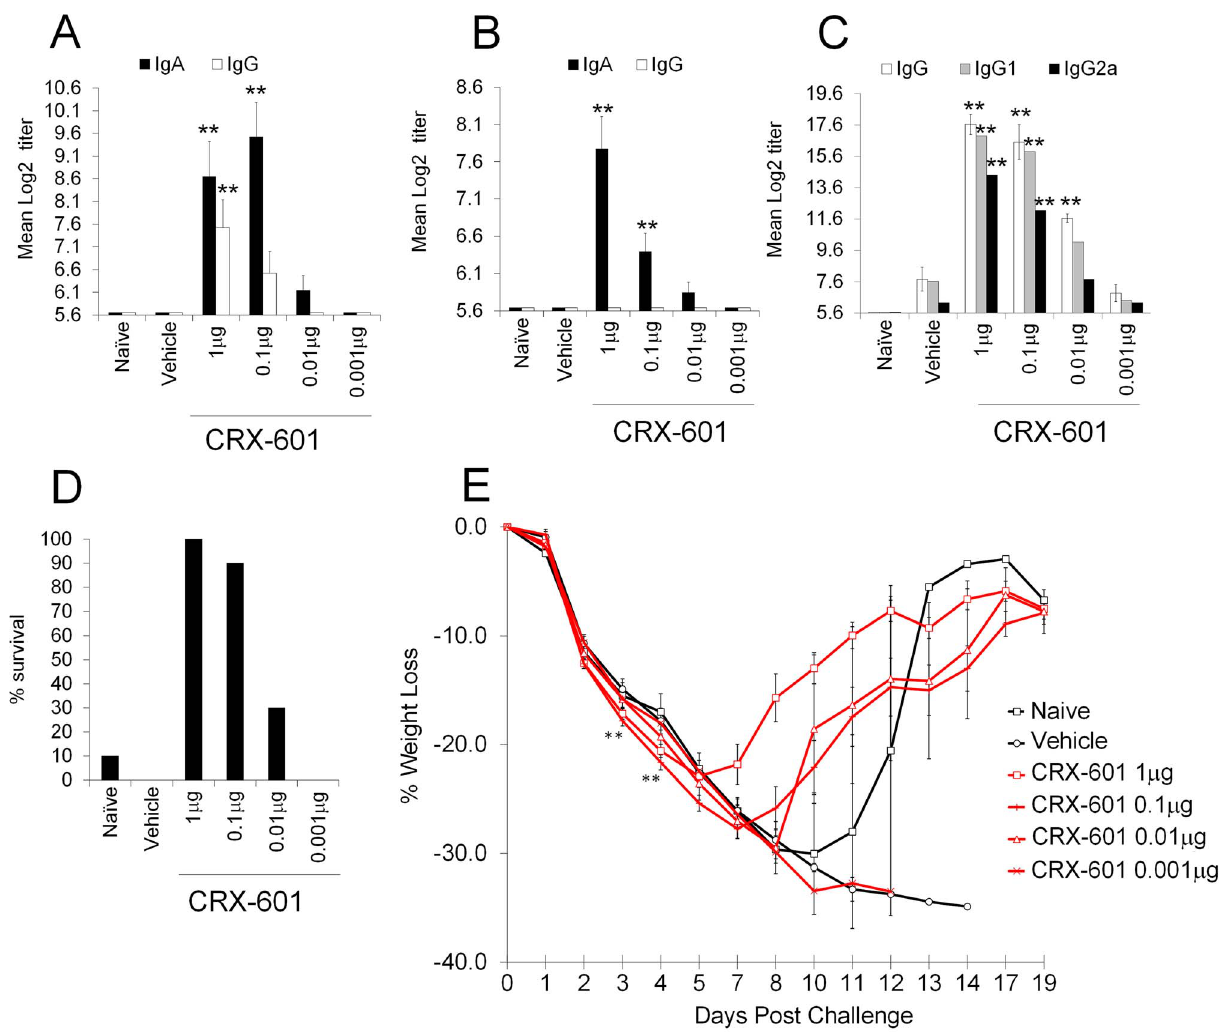
Figure 3. Intranasal vaccination induces both mucosal and systemic immune responses. Anti-influenza total IgG and IgA titers in vaginal (A) and tracheal wash (B) as well as total IgG, IgG1, IgG2a titers in serum samples from mice vaccinated intranasally with split influenza virus antigen (A/Uruguay/716/2007 (H3N2)) and CRX-601 liposomes were examined 14 days post boost vaccination. Percent survival (D) and percentage weight change relative to starting weight (E) following challenge with A/Hong Kong/1968 (H3N2) influenza virus is shown. Data is representative of two independent experiments with 8 mice per group for antibody titers and 10 mice per group for influenza challenge. Data in A, B and C are means 6 SEM from 8 mice and E is means 6 SEM for 10 mice analyzed by one-way ANOVA, ** p , 0.01 denotes significance compared to vehicle control (Dunnet post-test).